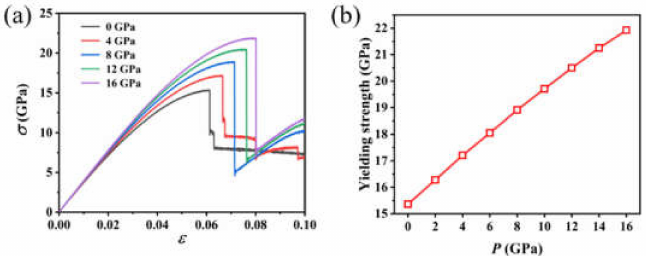
Figure 7. ( a ) Stress–strain curves of single-crystal tungsten under uniaxial tension at different pressures. ( b ) Yield strength of single-crystal tungsten as a function of pressure.